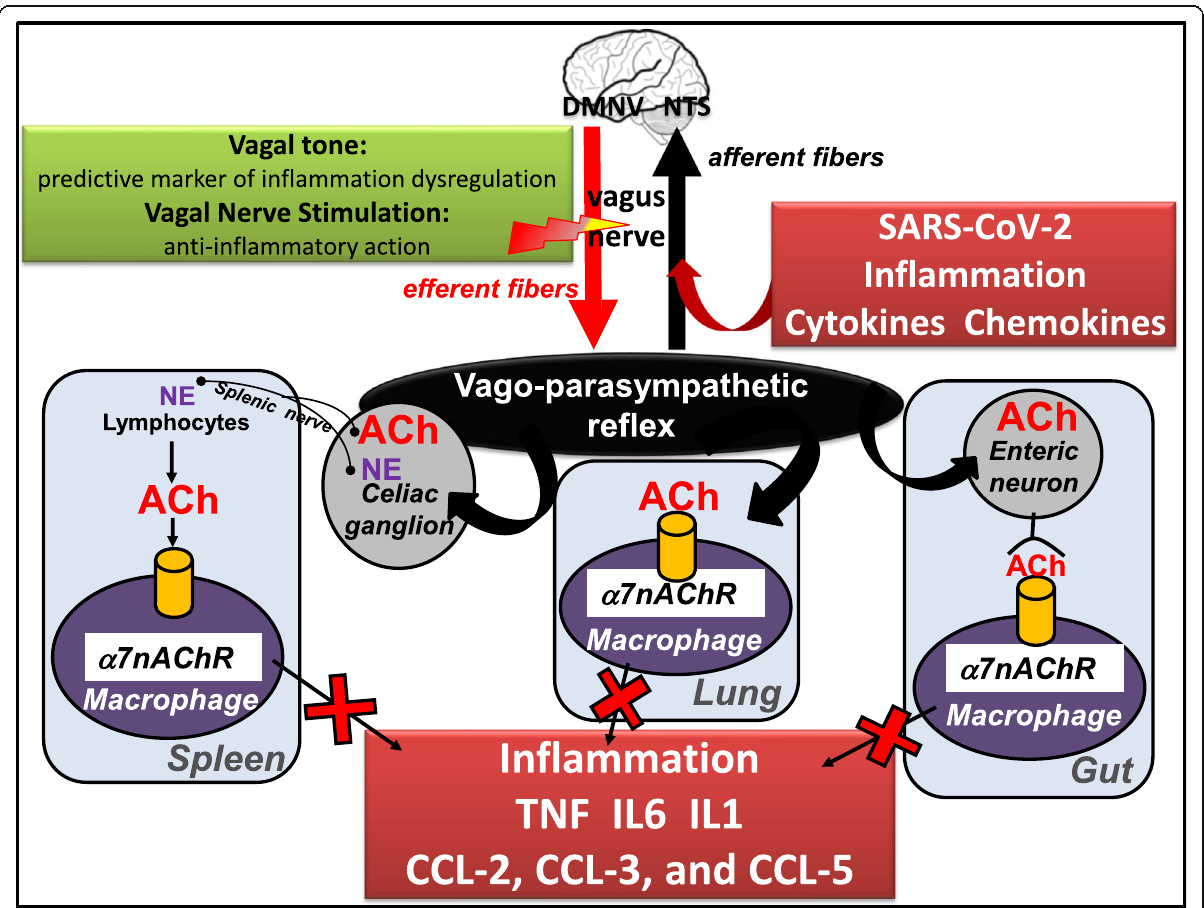
Fig. 1 Vagus nerve stimulation: an anti-inflammatory tool targeting nAChR at multilevel organs in COVID-19. DMNV, dorsal motor nucleus of the vagus; NE, norepinephrine; NTS, nucleus tractus